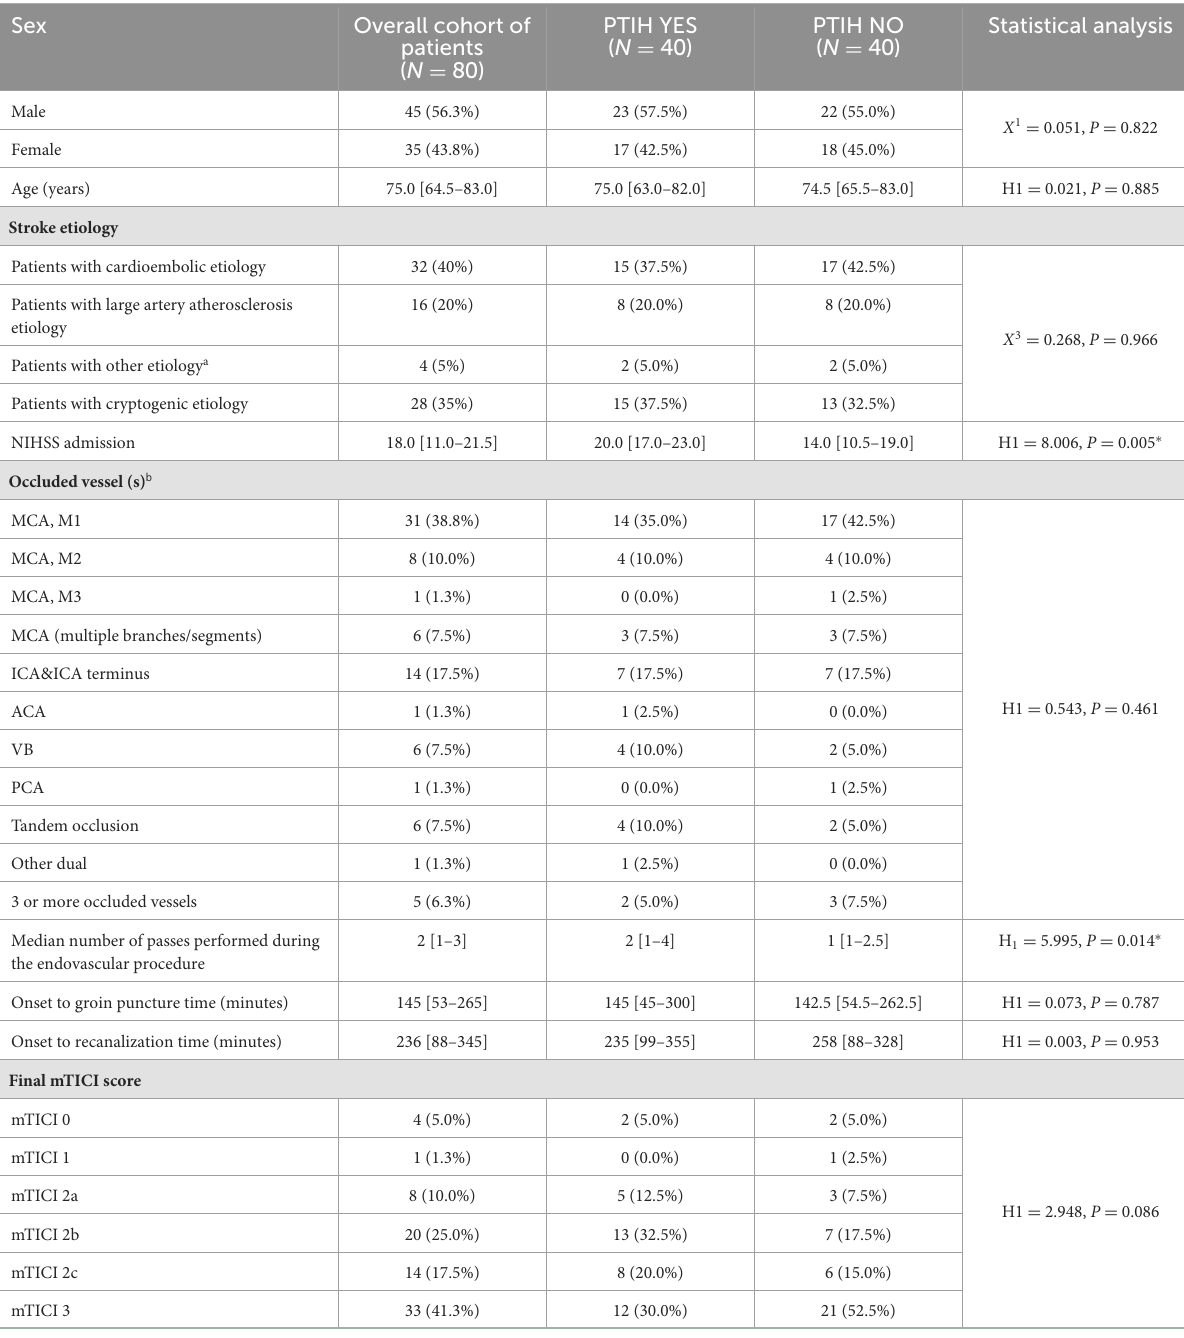
TABLE 1 Baseline clinical and procedural characteristics of the overall cohort of patients and divided according whether they had or not post-thrombectomy intracranial hemorrhage (PTIH). Sex Overall cohort of